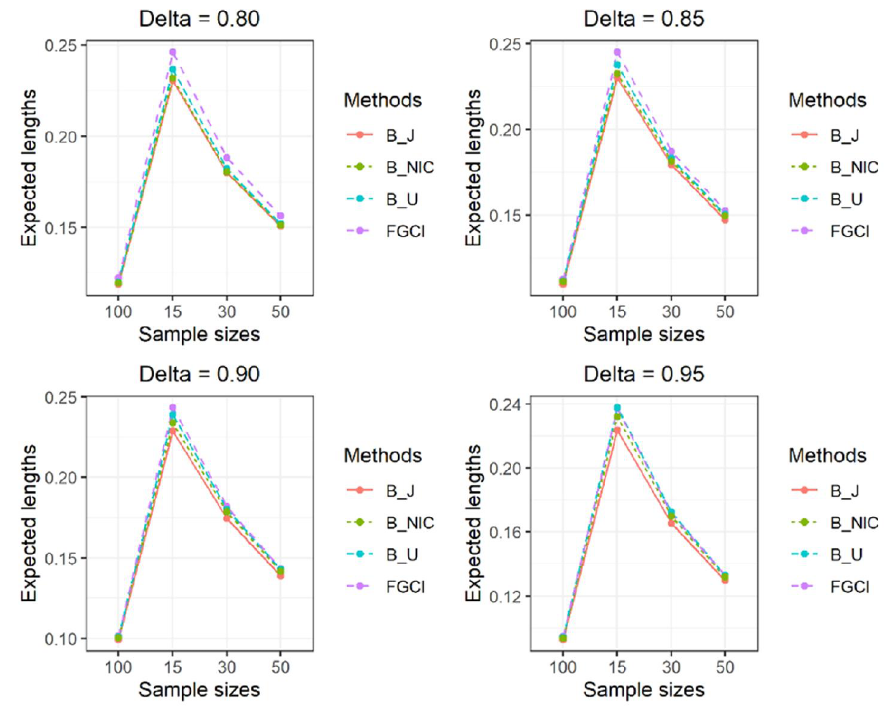
Figure 3. The expected lengths of the 95% confidence intervals and the credible intervals for the CQV by the probabilities of non-zero values.